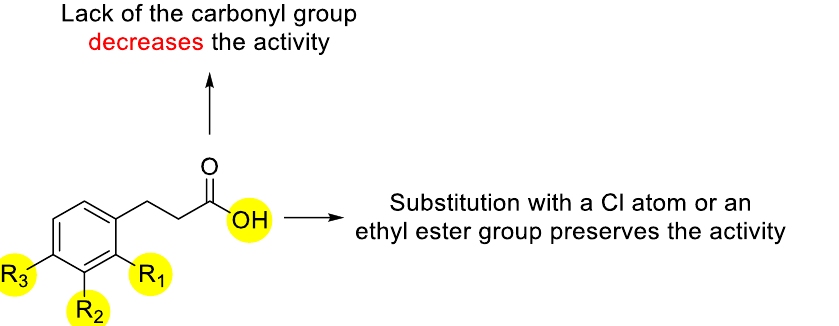
Figure 3. Structure – activity relationship of hydrocinnamic acid regarding the inhibitory activity on Cuscuta growth.